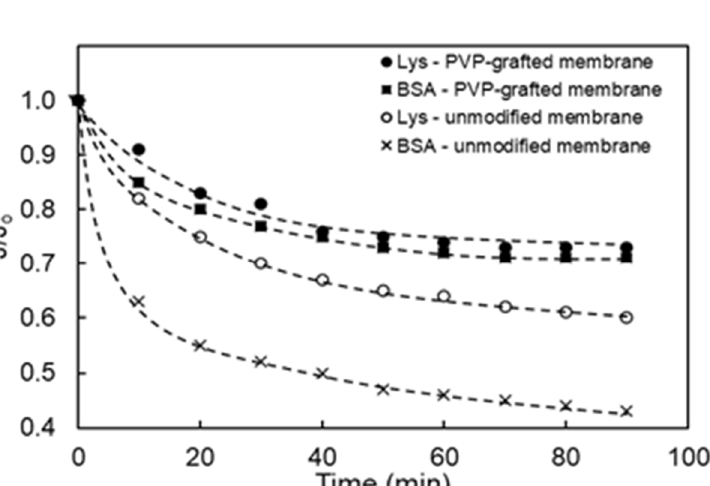
Figure A2. Flux decline curves for the unmodified Carbosep M1 and PVP-ZrO 2 membranes filtration of BSA and Lys solutions in terms of the normalized flux decline with unmodified and PVP-ZrO 2 Carbosep M1 membranes at ionic strength of 0.1 M NaCl and pH of 7.